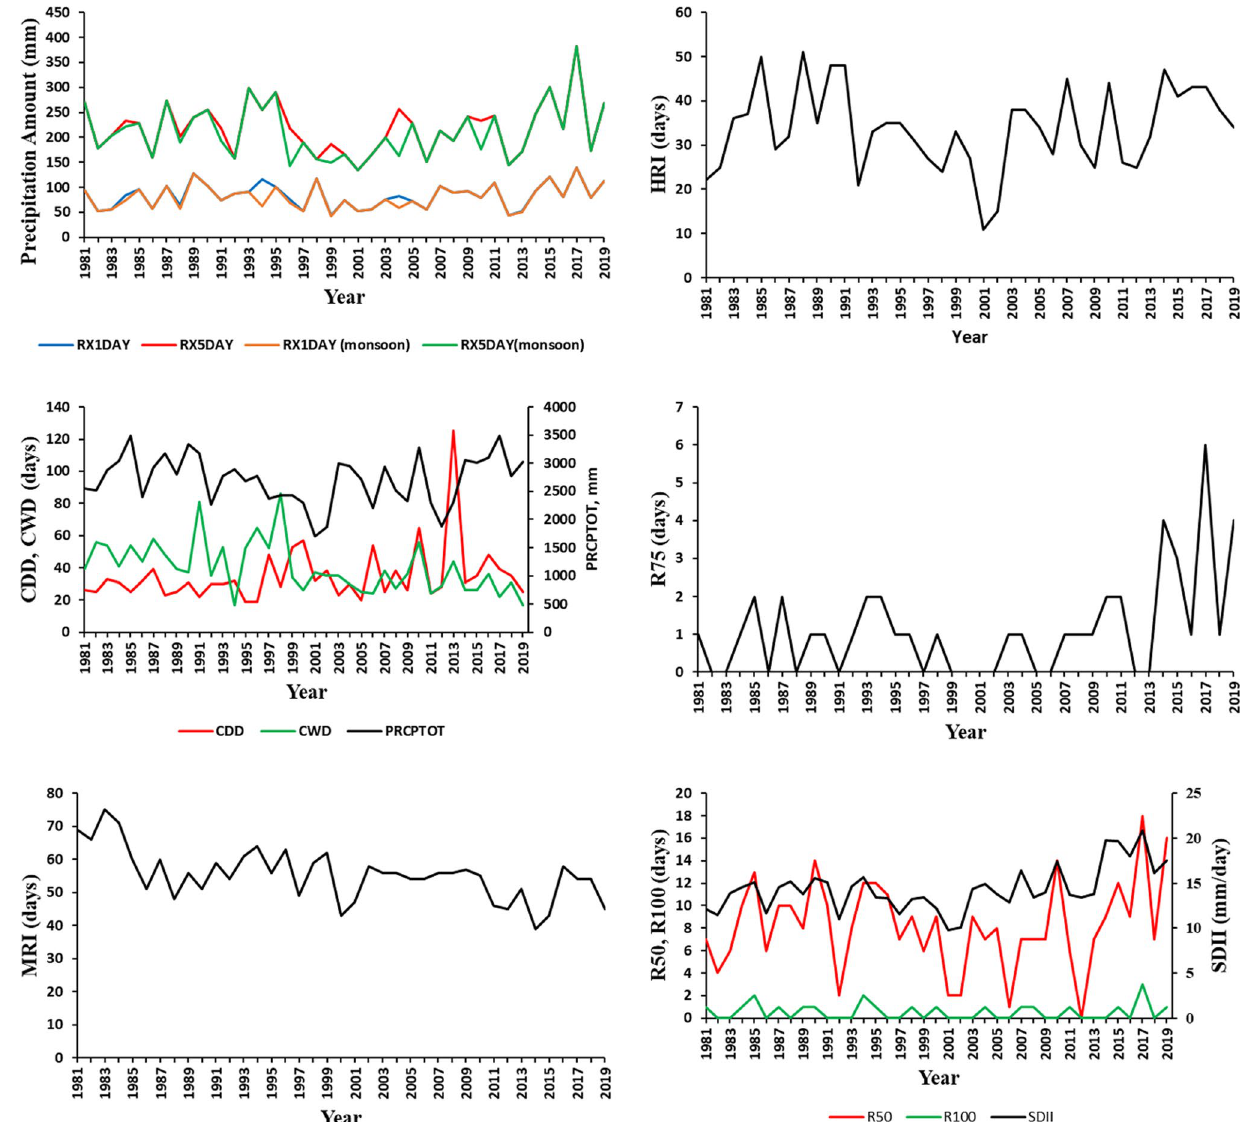
Fig. 4 RX1DAY, RX5DAY, RX1DAY (monsoon), RX5DAY (monsoon), CDD, CWD, PRCPTOT, MRI, HRI, R50, R75, R100 and SDII of